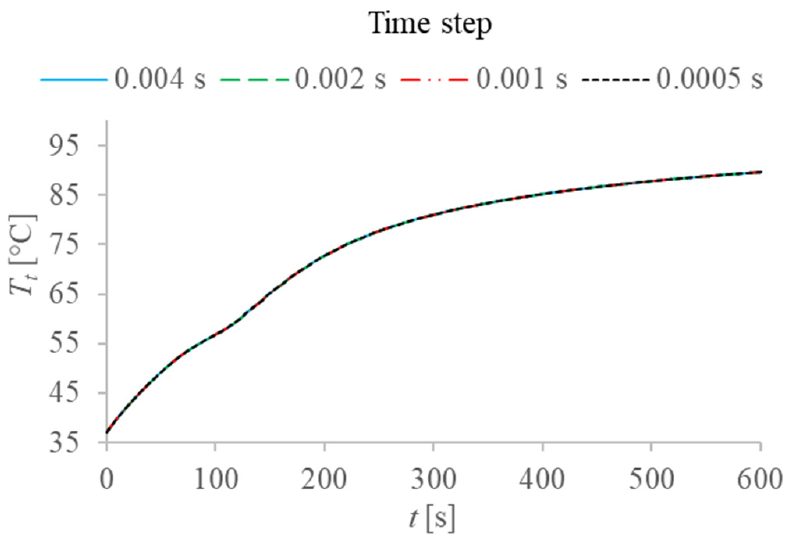
Figure 4. Evaluation of different time steps on temperature profile at tumor rim ( r = 1.2 cm; z = 0.0 cm).